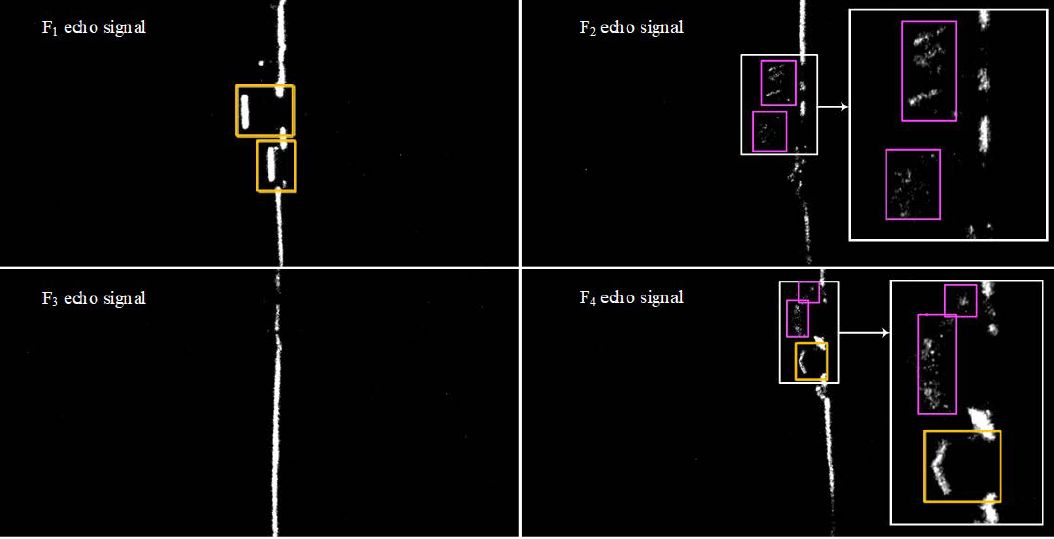
Figure 2. Echo signals in the scene of Figure 1b; The boxes with white border show the local details of the signal; Signals representing trees and buildings are marked by boxes with pink and orange borders, respectively.